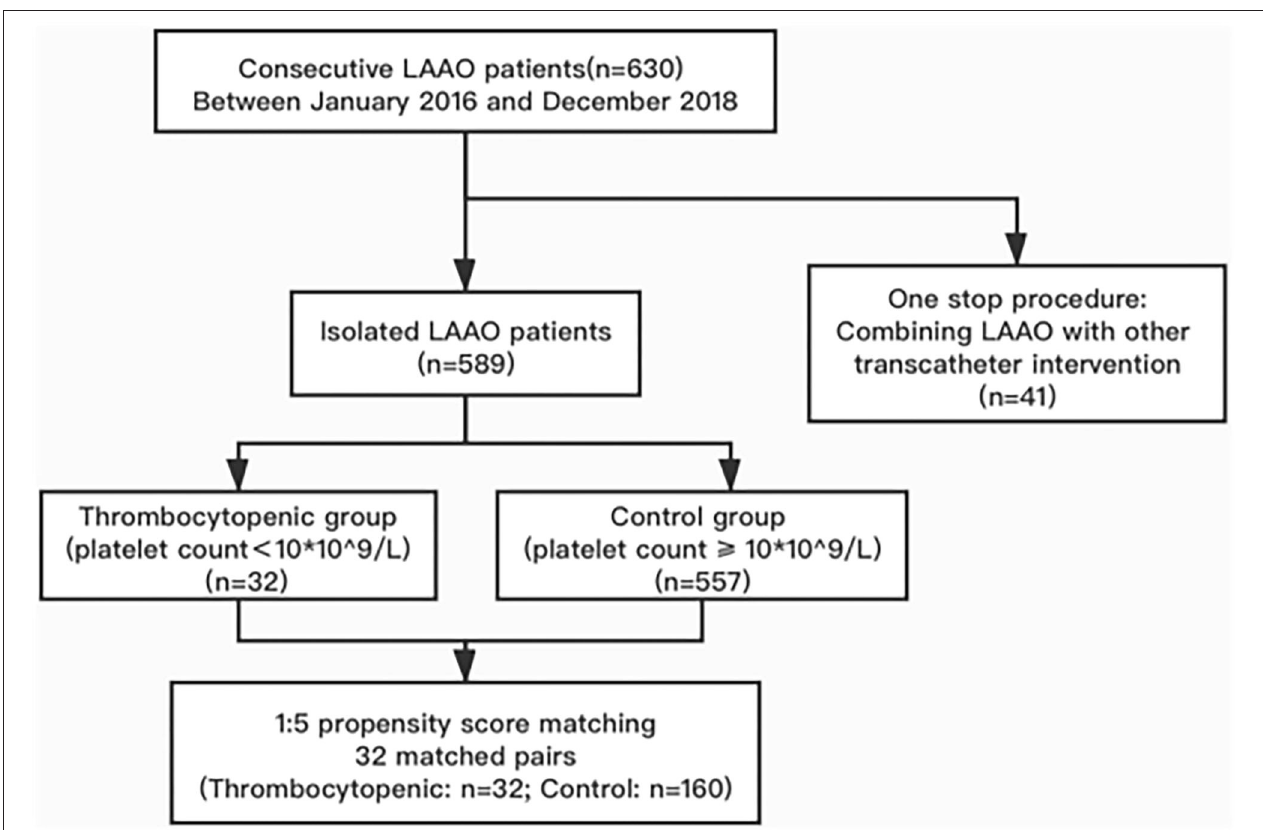
FIGURE 1 | Study flow diagram: the incidence of efficacy and safety outcomes were identified from 32 matched pairs of 193 consecutive patients indicated for LAA implantation.